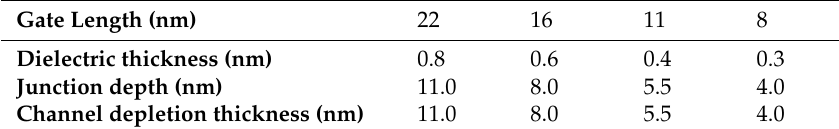
Table 1. Key geometric parameters for several technology nodes [1].